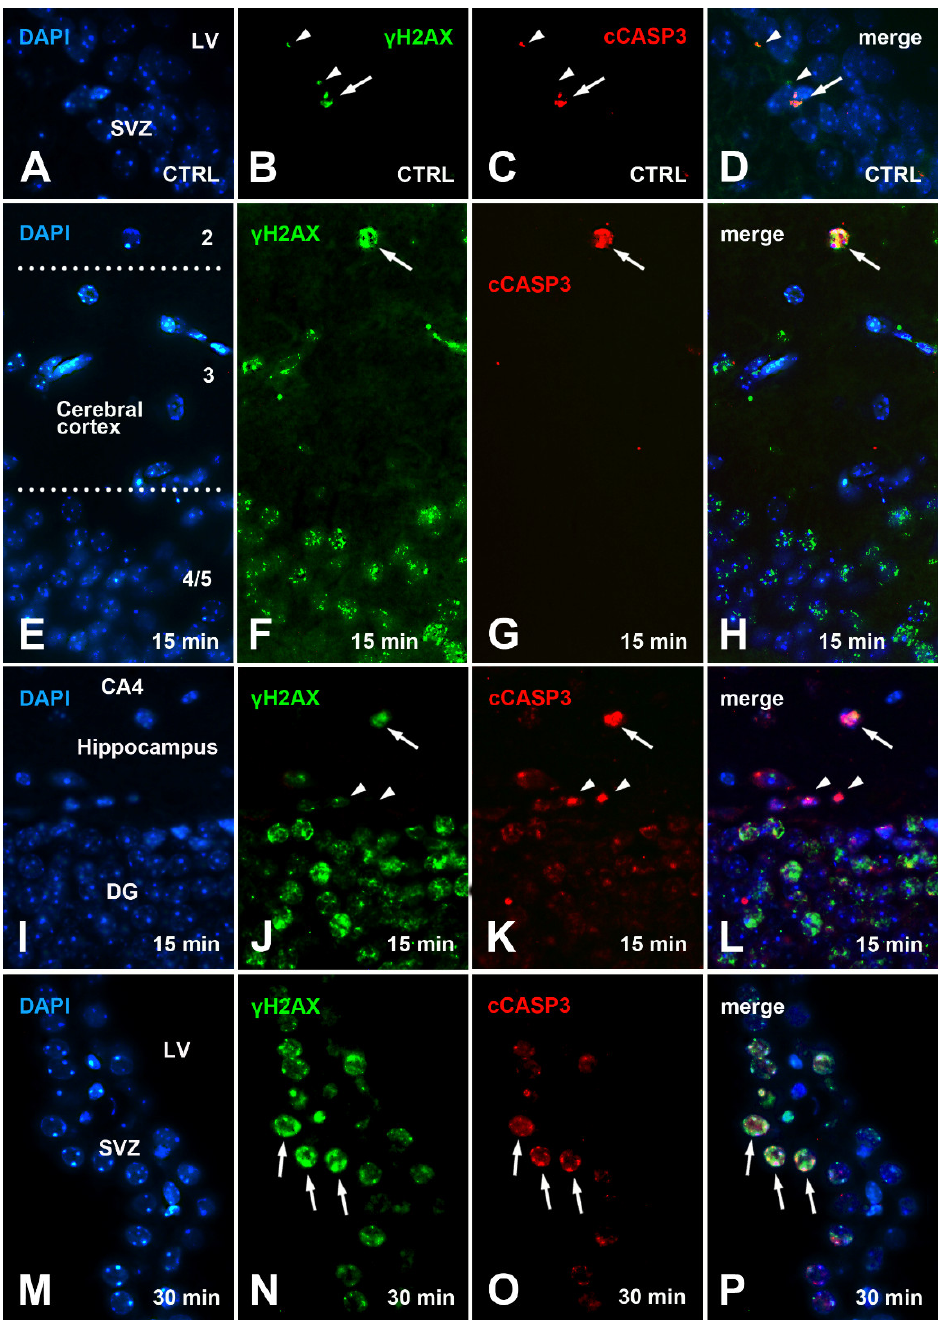
Figure 7. Exemplificative wide-field IMF images of γH2AX and cCASP3 immunoreactive cells in control and irradiated mice. ( A – D ) Localization of γH2AX and cCASP3 in a cell with apoptotic con- densation (arrow) and apoptotic cell bodies (arrowheads) within the SVZ of a control not-irradiated mouse. ( E – H ) An apoptotic double-labeled cell (arrow) in layer 2 of the cerebral cortex of a mouse that survived 15 min following irradiation. ( I – L ) An apoptotic double-labeled cell (arrow) in the hippocampal CA4 field of a mouse surviving 15 min following irradiation. The arrowheads point to two condensed apoptotic bodies displaying cCASP3 immunoreactivity. Note that the one at left also shows a small focus of γ H2AX positivity (panel J). ( M – P ) Several double-labeled cells in the SVZ after 30 min survival. The arrows indicate three γ H2AX+cCASP3 positive cells. Abbreviations: CA = Cornu Ammonis ; CTRL = control; DG = hippocampal dentate gyrus. Arabic numerals in € indicate cortical layers. Original magnifications 63 ×